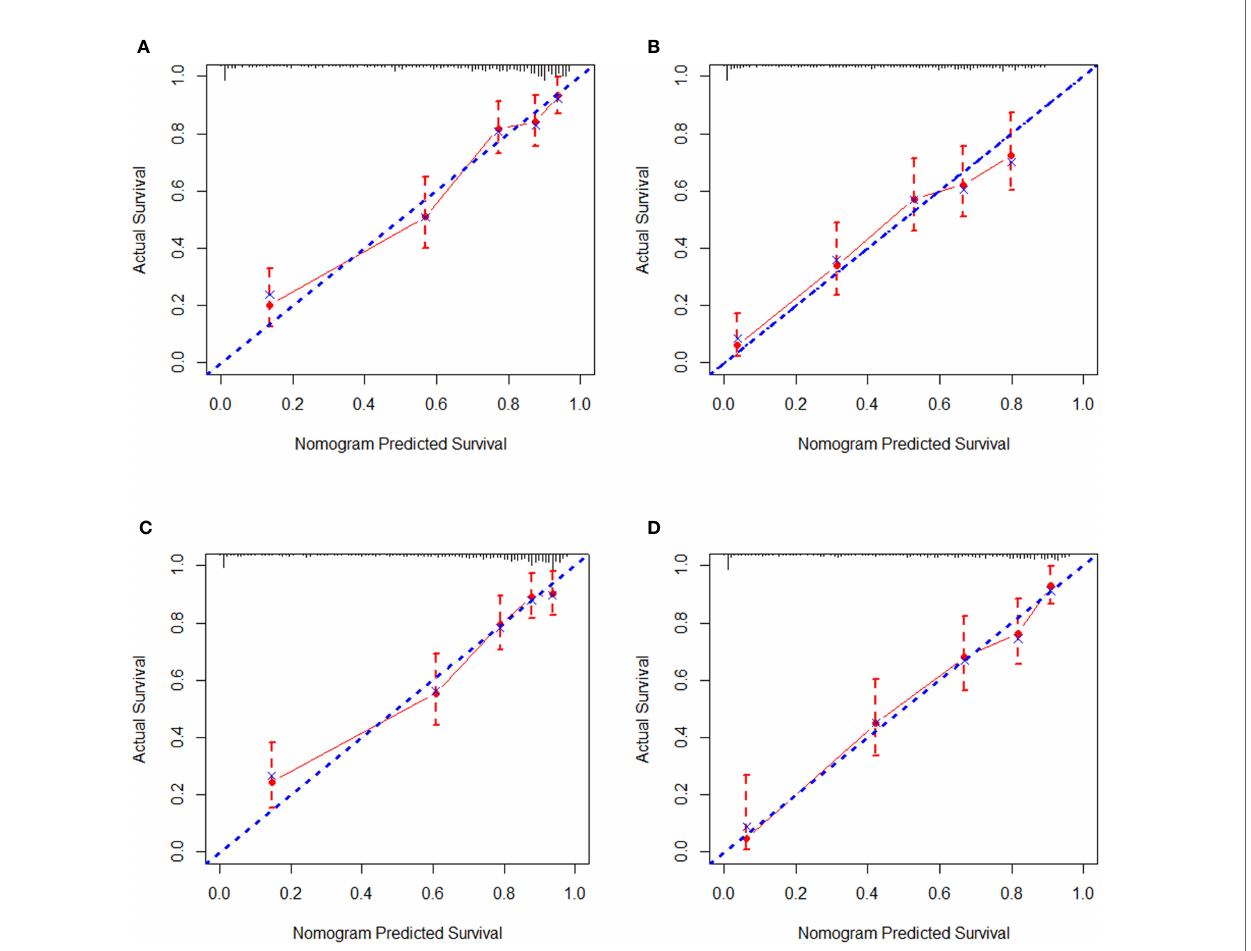
FIGURE 3 | Internal calibration curves in the training cohort. (A) The 3-year and (B) 5-year overall survival (OS) nomogram calibration curves. (C) The 3-year and (D) 5-year cancer-speci fi c survival (CSS) nomogram calibration